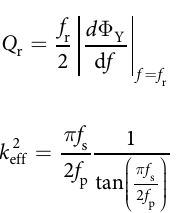
Figure 5(b,c) are obtained by extracting Q r and k eff2 of 25 devices from each set and calculating the average values and standard deviation (error bars) in each direction from the mean value. SMRs with ZnO grown on Al deposited at 100 °C has the highest shear mode Q r (155 ± 25). Therefore the optimum T S for the electrode surface is estimated to be 100 °C. At this temperature, the Al surface has the ideal roughness to promote the homogeneous growth of the inclined ZnO, achieving a Q r as high as 180. This value decreases at higher T S because of the increased roughness (causing an increased series resistance of the Al electrode), which leads to additional scatter- ing at the ZnO-Al interface resulting in parasitic losses that reduce Q r . At lower T S , the shear mode is not effec- tively excited leading to both a lower Q r and k eff2 . This can probably be because the Al surface has low roughness, which is not sufficient to favor the a continuous inclined c -axis orientation in the ZnO grains, as shown by the lower and inhomogeneous inclination angles of ZnO when T S = 25 °C. Despite the high k eff2 ((3.6 ± 0.5)%) observed in Fig. 5(c) for T S = 300 °C, the devices grown with Al at this temperature are stressed and delaminated quickly, which rendered them unsuitable for biosensing experiments. The high k eff2 at T S = 300 °C can be explained